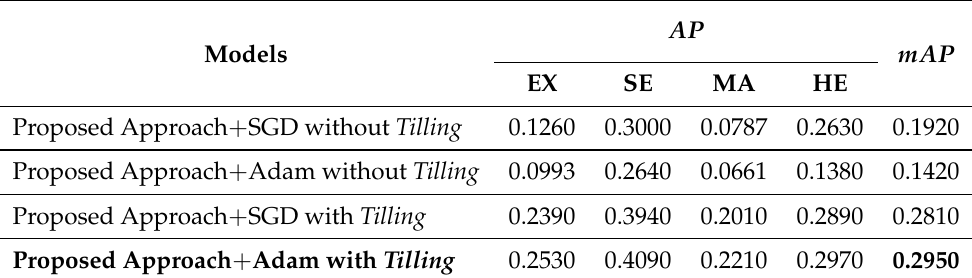
Table 11. Results obtained by the proposed approach with Tilling and the SGD and Adam optimizers with the metrics AP and mAP for the Intersection over Union threshold of 0.5 in the test set of the Indian Diabetic Retinopathy Image Dataset (IDRiD).